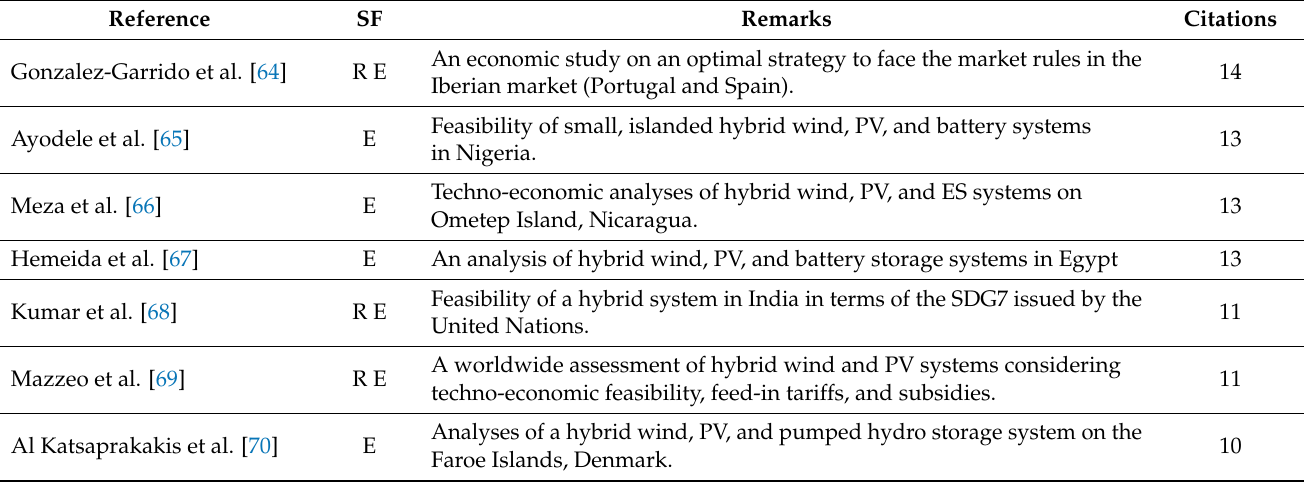
Table 3. Most-cited articles in the sample published in 2019 or 2020 with 10 to 15 citations.